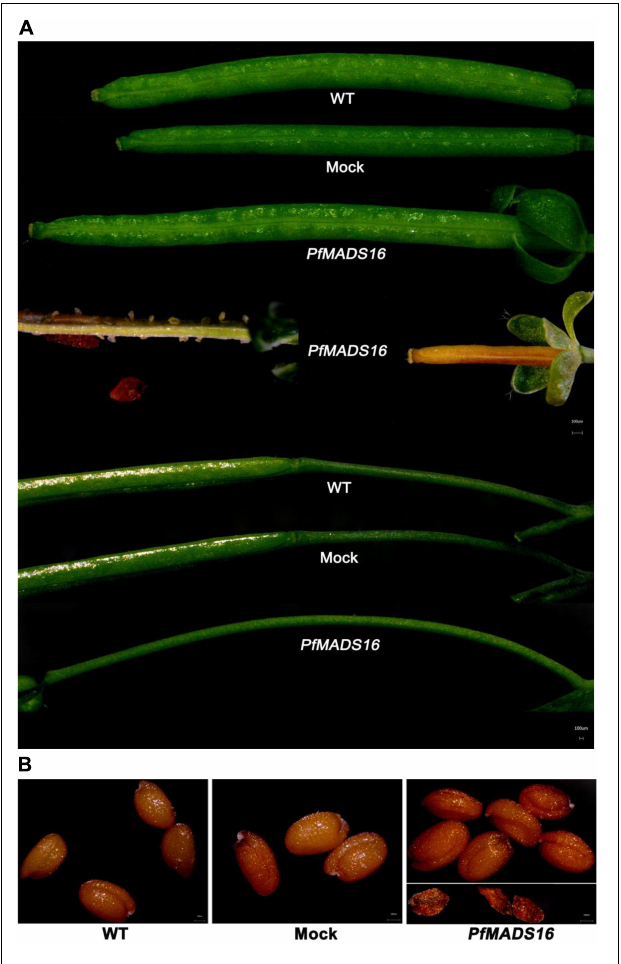
FIGURE 3 | Phenotypic abnormalities in podding of representative PfMADS16 transgenic Arabidopsis plants as compared to WT and Mock plants. (A) PfMADS16 transgenic plants exhibiting different pod types (long and short), sepals that do not fall off at maturity, and elongated pedicels. (B) PfMADS16 transgenic plants with aborted seeds. Similar results were observed among T3 transgenic lines.